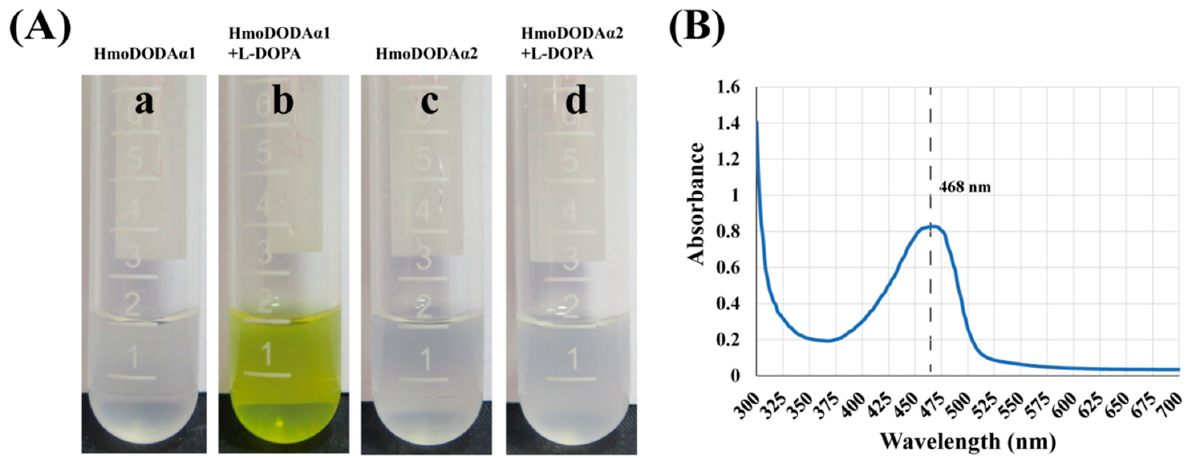
Figure 7. Expression of HmoDODA α 1 and HmoDODA α 2 in yeast. ( A ) Visual appearance of yeast strains after expression of HmoDODA α 1 and HmoDODA α 2 . The yeast strains only harboring HmoDODA α 1 or HmoDODA α 2 . ( a ) Yeast expressing HmoDODA α 1 without L-DOPA. ( b ) Yeast expressing HpDODA α 1 with L-DOPA. ( c ) Yeast expressing HmoDODA α 2 without L-DOPA. ( d ) Yeast expressing HmoDODA α 2 with L-DOPA. ( B ) Maximum absorption of the pigment.